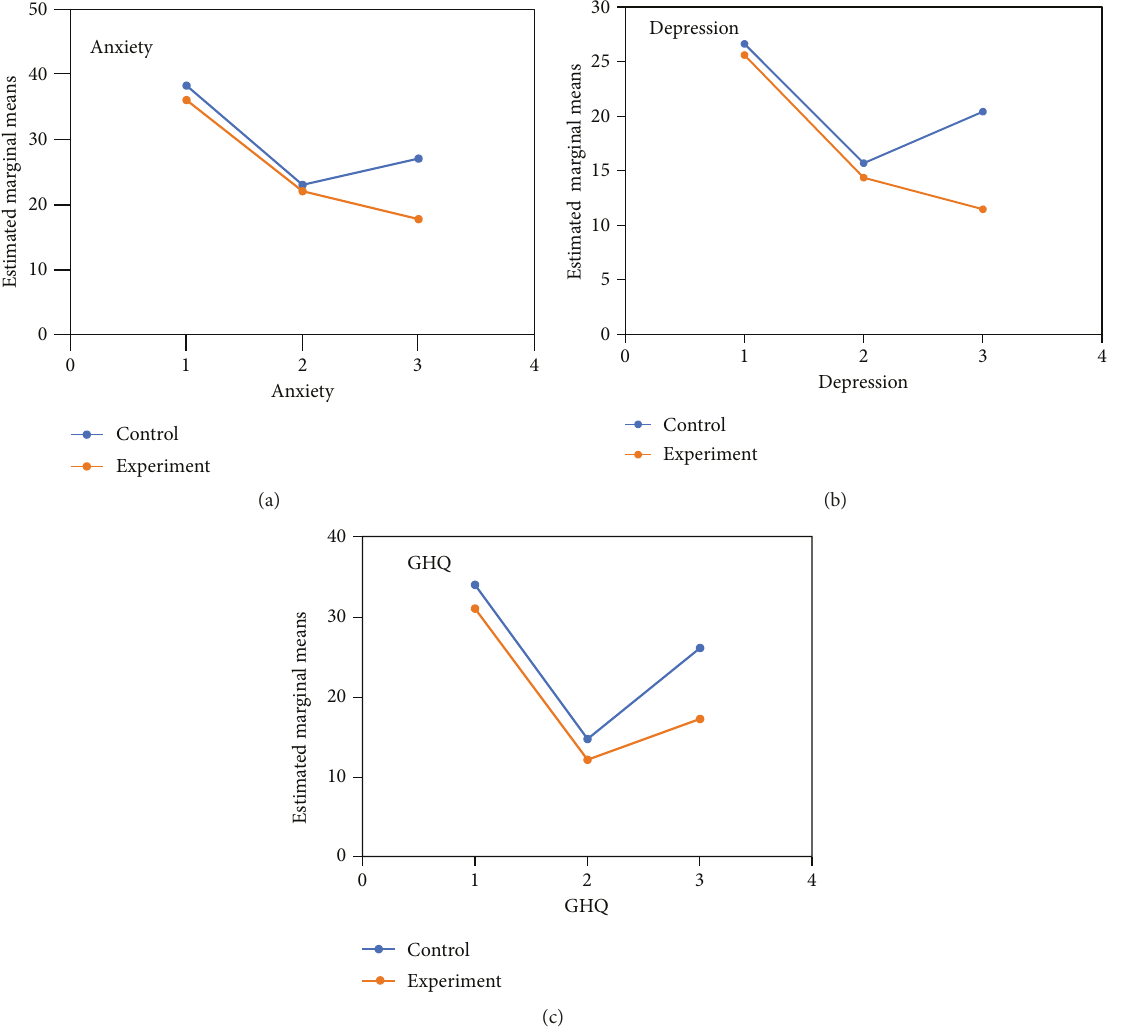
Figure 2: The trajectory of changes in mental health measures (GHQ-28 score, HARS score, and HDRS score) in the intervention and control groups during the time of study (1 =baseline, 2=8 weeks, 3=3